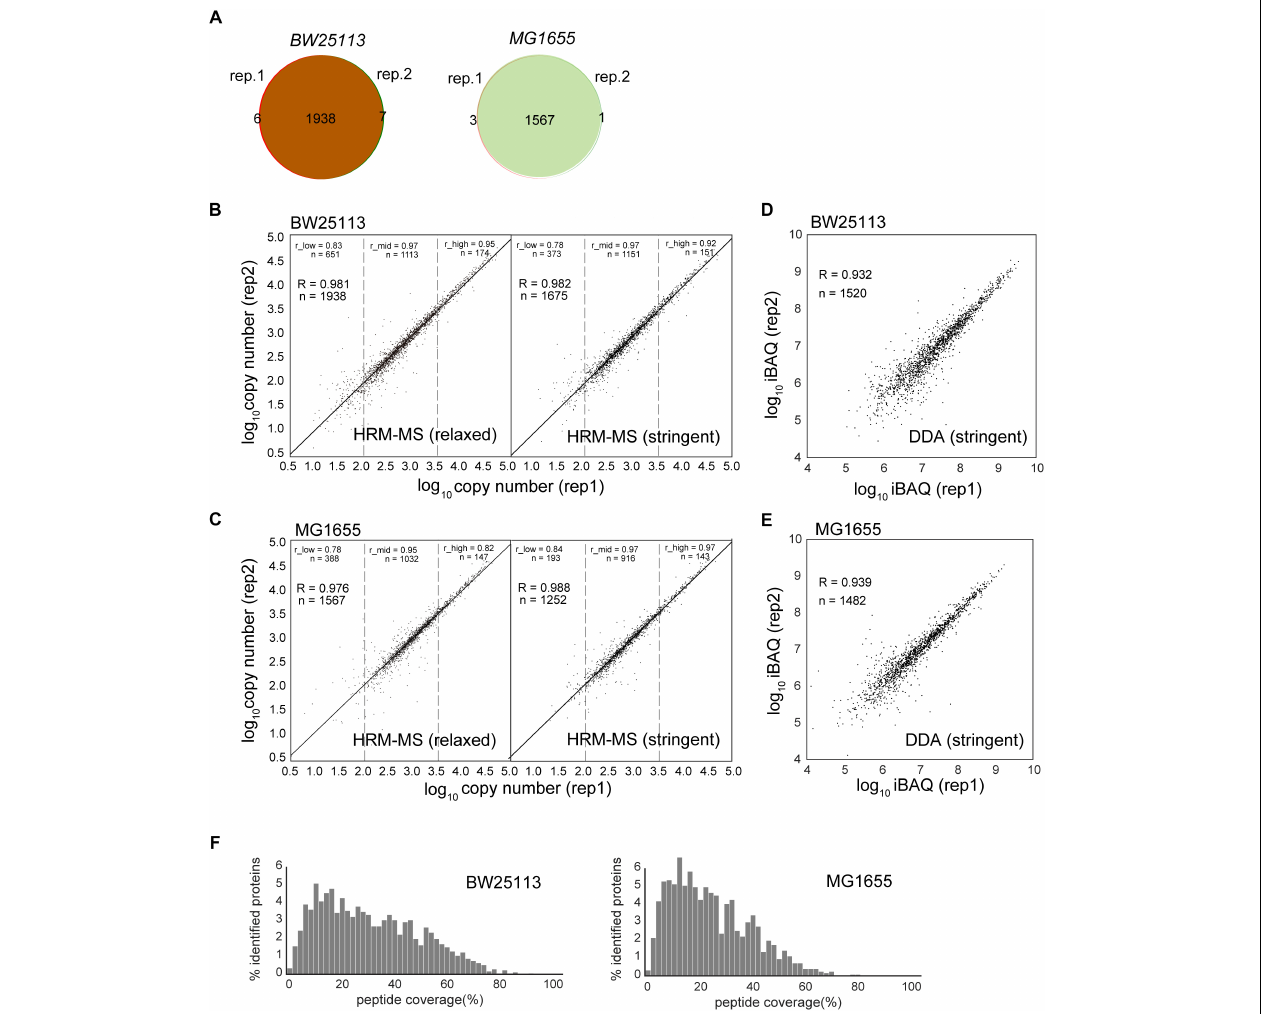
FIGURE 1 | Comparison of protein abundances obtained by different label-free quantification methods. (A) Quantified protein numbers in two biological replications of HRM-MS method of two strains. (B,C) The quantification reproducibility of HRM-MS method in relaxed and stringent criteria of two E. coli strains, respectively. R is the Pearson correlation coefficient. The protein abundance range was divided into low ( < 2.0 log scale), mid (2.0–3.5 log scale) and high ( > 3.5 log scale) sections. r_low, r_mid and r_high are the Pearson correlation of the proteins in these sections. (D,E) The reproducibility of DDA MS experiment of the two strains. Proteins were quantified using iBAQ method. (F) The peptide coverage of the HRM-MS-identified proteins in two E. coli strains,